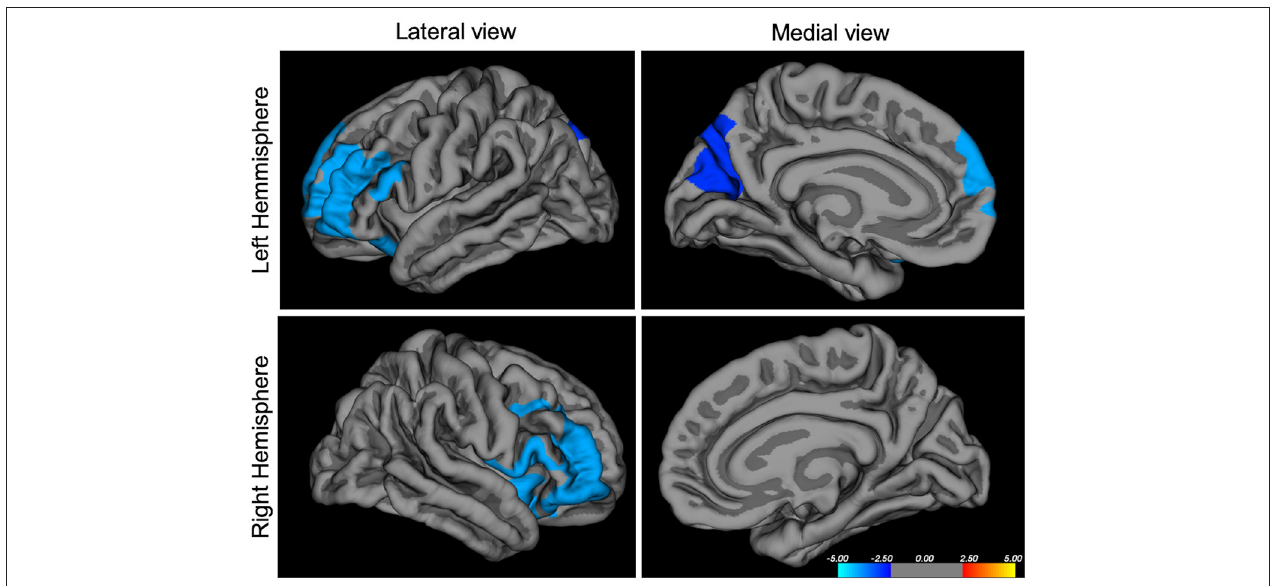
FIGURE 1 | Negative correlation between ARI-parents score and cortical surface area in mm 3 , p < 0.05 corrected, N = 641. ARI, Affective Reactivity Index. The colors represent the –log 10 ( p -value at cluster level) with red indicating a positive correlation and blue indicating a negative correlation between scores and morphological